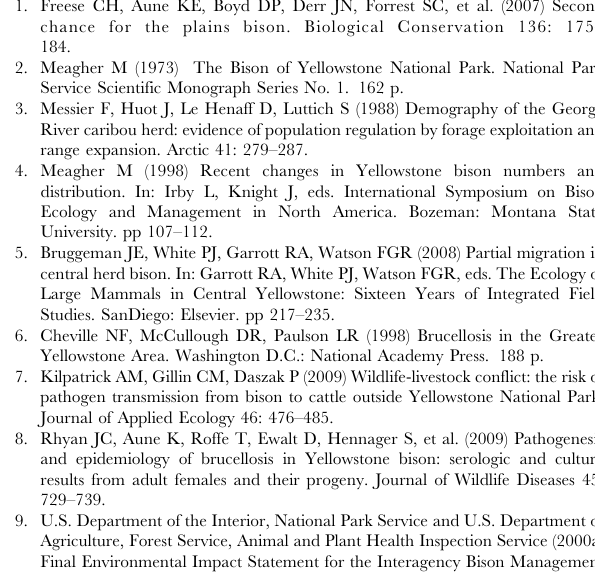
Table values indicate approximate maxima abundances with 95% probability, e.g. the probability that there will be no more than the listed number of bison outside of the park is 0.95 given central and northern herd sizes, and accumulated SWE (snow) and aboveground dry biomass (forage) as percentages of 20-year